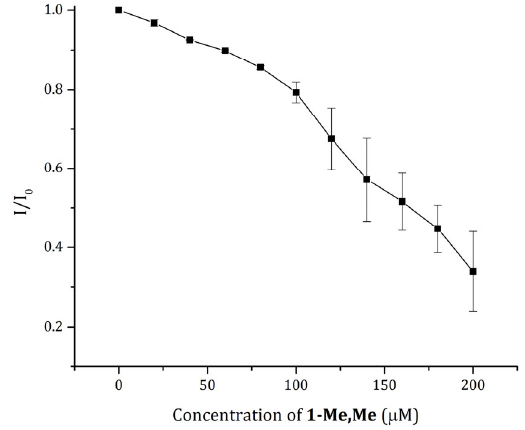
Figure 7. Fluorescence quenching of a 20 µ M EB-DNA complex upon titration with a solution of 1-Me,Me in 0.05 M of ammonium acetate at a pH of 7.5, reported as a function of the Pt compound concentration.